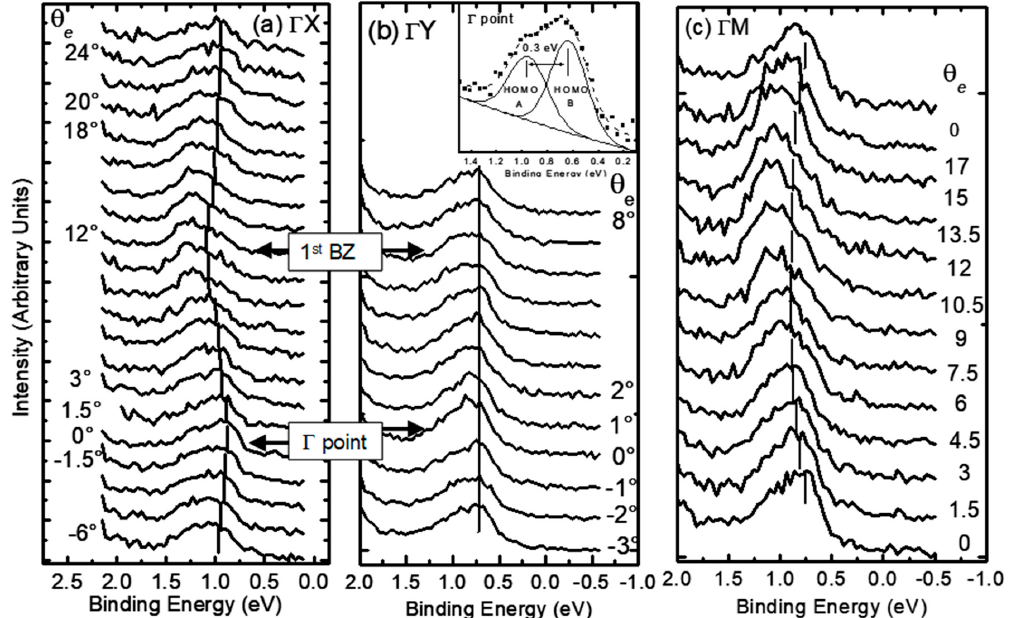
Figure 6. Evolution of the highest occupied molecular orbital (HOMO) region in the rubrene ARPES spectra as a function of electron emission angle ( θ ) for single crystal rubrene along ( a ) Γ X, ( b ) Γ Y, and ( c ) Γ M direction. The spectra are plotted in binding energy relative to the Fermi level. The boundaries of the 1st Brillouin Zone are noted by arrows. The inset shows the peak decomposition of the HOMO feature at Γ point. The evolution of the HOMO-B along Γ X direction is noted by short bars. From Ref. [68] with permission.